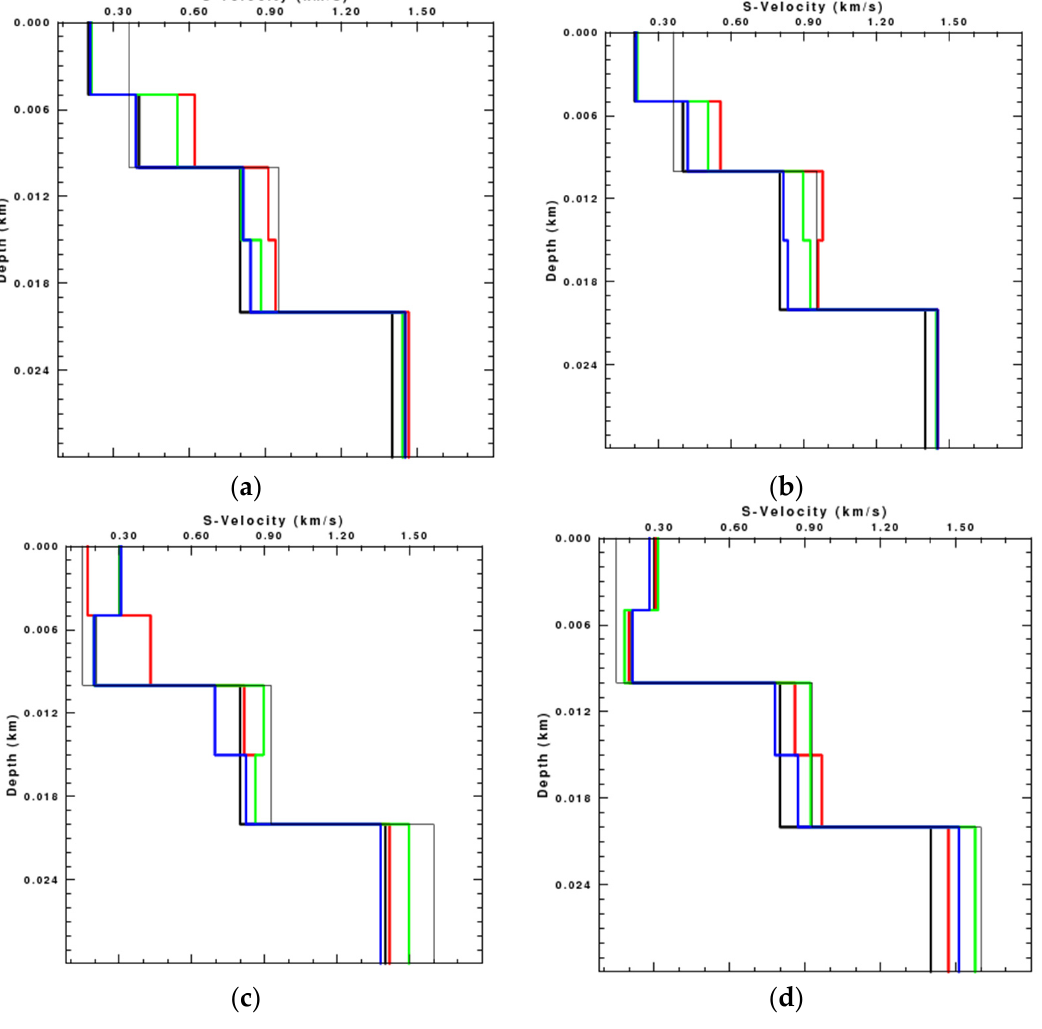
Figure 10. Inversion results of the noisy data using the radial (red line), vertical (green line), and rotational (blue line) components, respectively. The black thick line is the theoretical S-wave velocity and the black thin line is the initial S-wave velocity. SNR of the left column is 2.8 and SNR of the right column is 1.7. ( a ) Model 1; ( b ) Model 1; ( c ) Model 2; ( d ) Model 2.